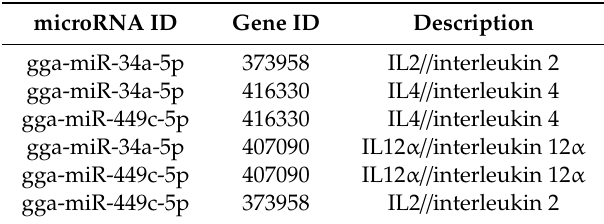
Table 1. The selected target genes of